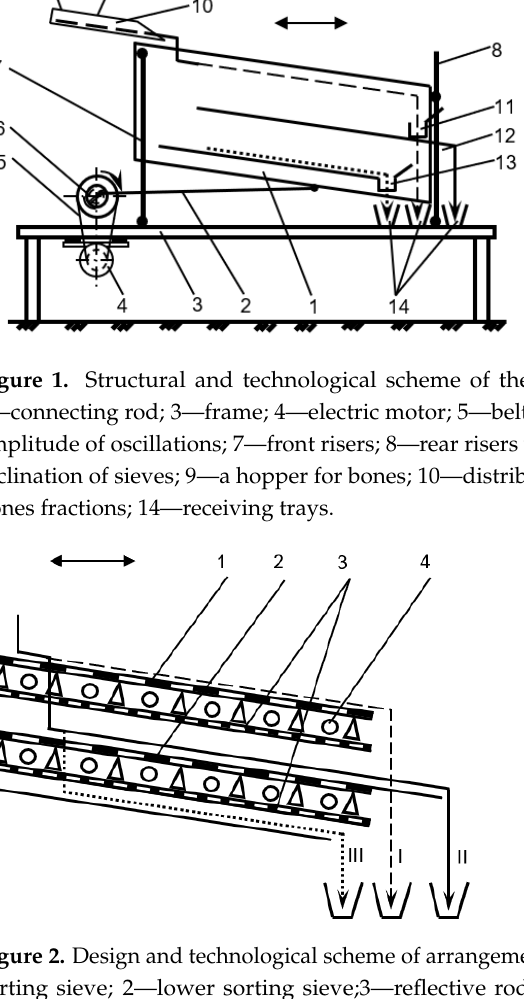
Figure 1. Structural and technological scheme of the calibration unit. 1 — the unit sieves part; 2 — connecting rod; 3 — frame; 4 — electric motor; 5 — belt transmission; 6 — a shaft with regula- tion of amplitude of oscillations; 7 — front risers; 8 — rear risers with a mechanism for ad- justing the angle of inclination of sieves; 9 — a hopper for bones; 10 — distribution board; 11, 12,13 — trays for removal of bones fractions; 14 — receiving trays.